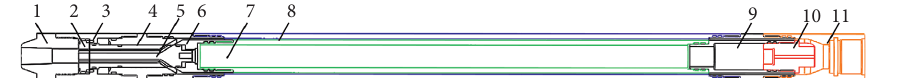
Figure 1: Mechanical structure of wireless control throttle. 1, inlet nozzle; 2, static flap; 3, adapter sleeve; 4, valve body; 5, dynamic flap; 6, adapter sleeve; 7, electric sealing cylinder; 8, air guide cylinder; 9, fixing frame; 10, head; 11,